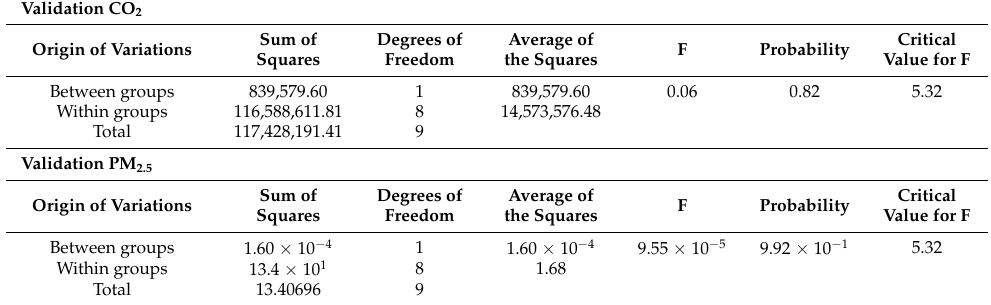
Table 6. Model validation for CO 2 and PM 2.5 using ANOVA testing hypothesis.